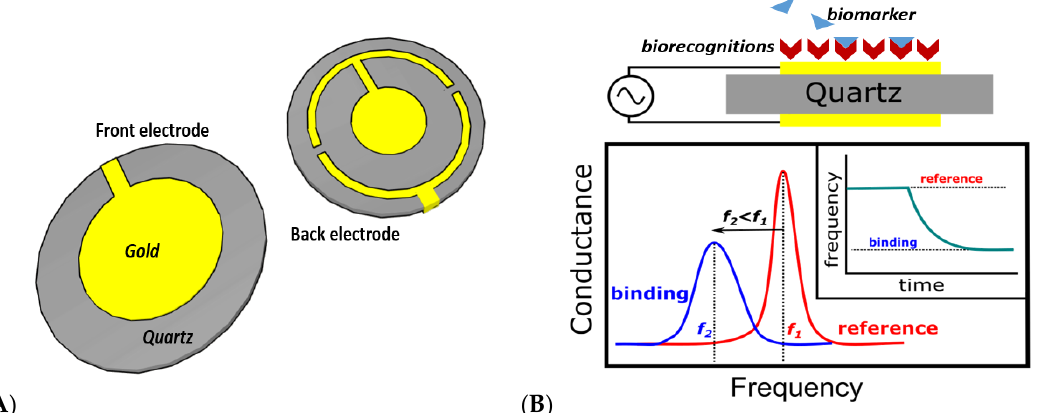
Figure 3. ( A ) Typical QCM electrodes. ( B ) Schematic circuit of a QCM with a frequency supply in the range from kHz to MHz (top). A frequency drop indicates the loaded electrode during the QCM measurement (bottom). The real-time measurement strategy in a QCM monitors the resonance frequency shifting (inset).